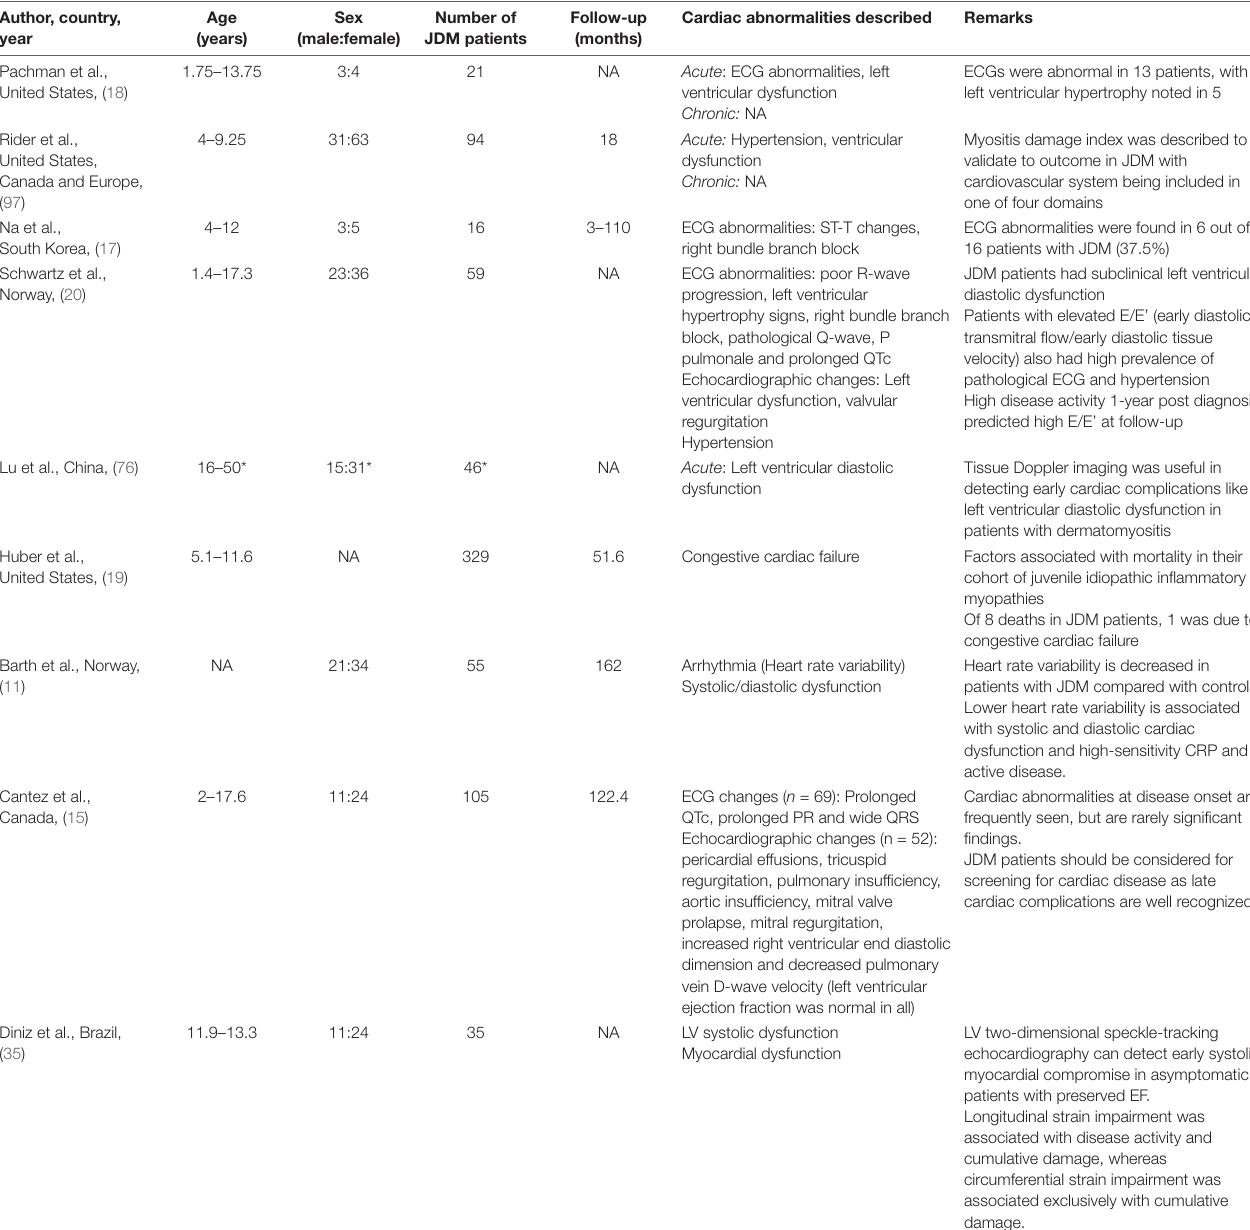
TABLE 1 | Previous studies on cardiovascular complications in children with JDM.